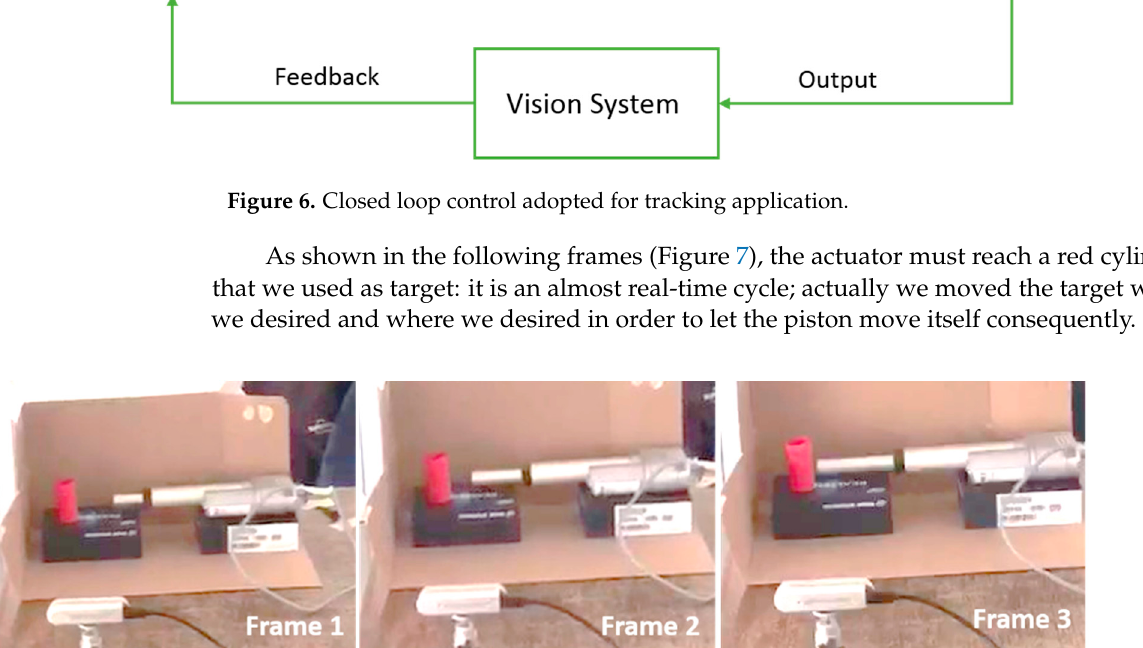
Figure 7. Three consecutive frames of target tracking application.